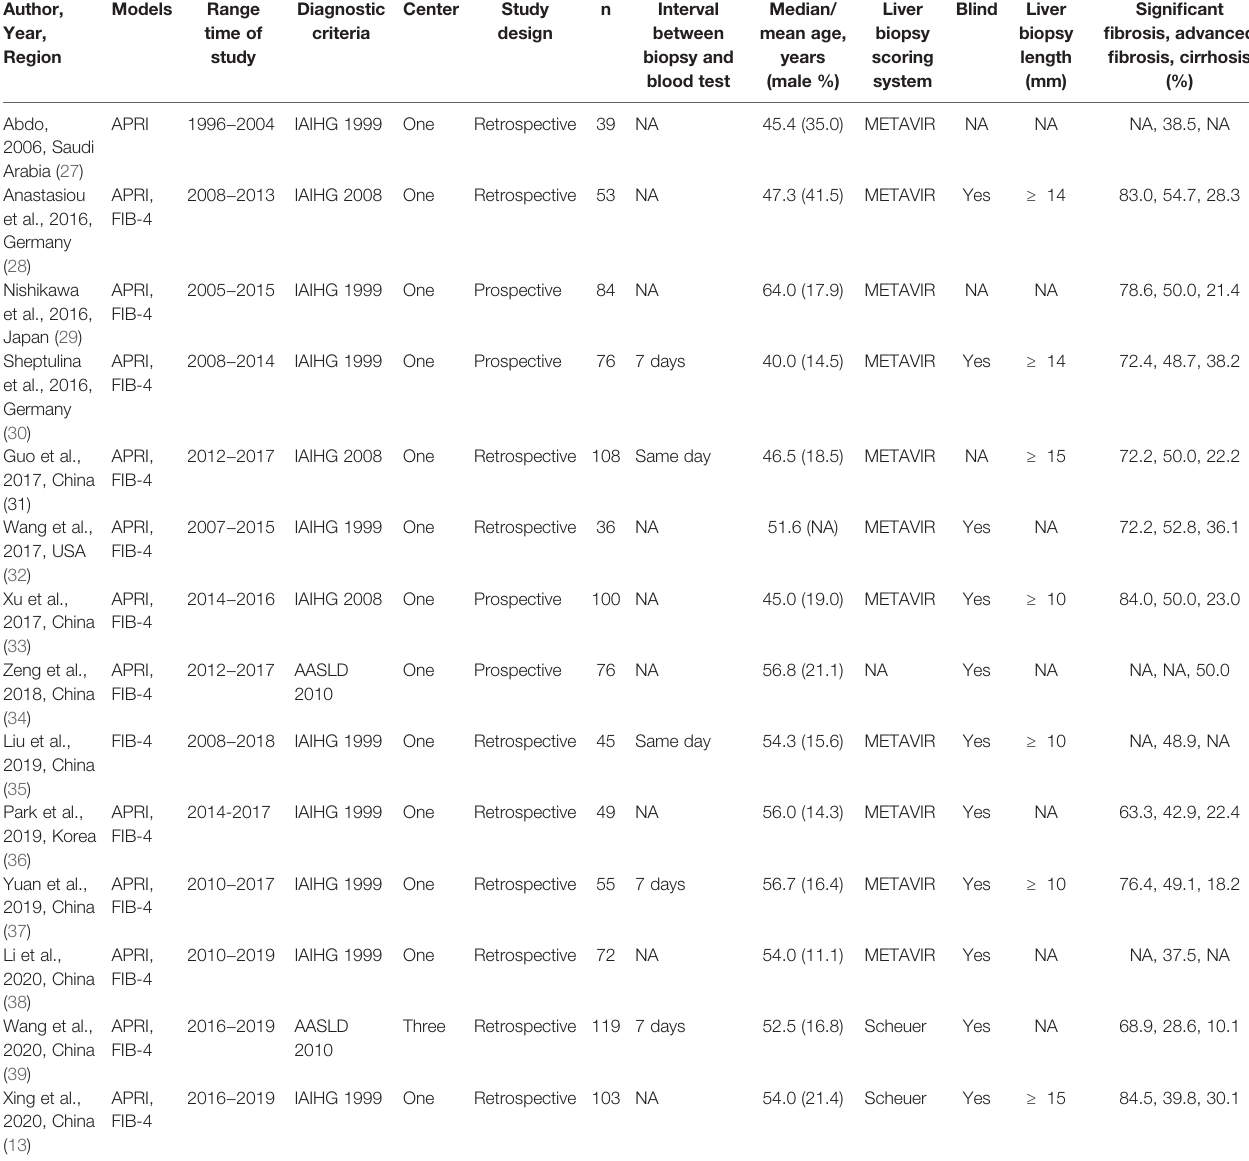
TABLE 1 | Main characteristics of studies included in this